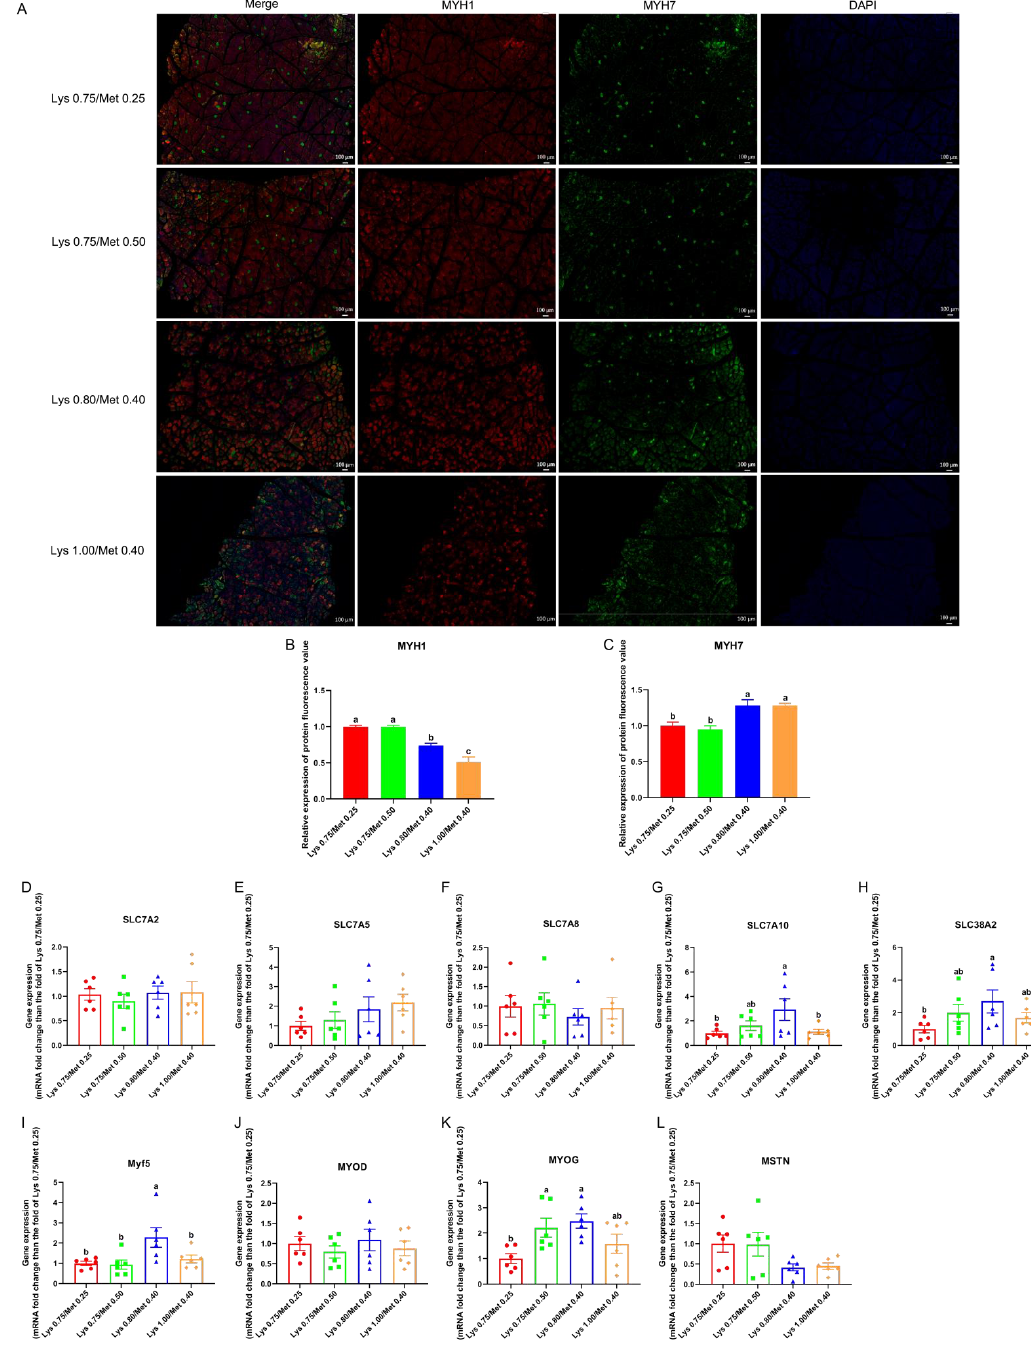
Figure 1. Effects of different lysine and methionine composition in diets on muscle fiber type and muscle tissue target gene expression in rabbits. ( A – C ) Muscle type detection (muscle tissue immunofluorescence). ( A ) MYH1 (red fluorescent, myosin–1; rabbit polyclonal fast myosin skeletal heavy chain antibody) and MYH7 (green fluorescent, myosin–7; rabbit polyclonal slow skeletal myosin heavy chain antibody). Quantification of MYH1 ( B ) fluorescence and MYH7 ( C ) fluorescence. ( D – H ): the expression of amino acid transporter protein-encoding genes. SLC7A2 (D), SLC7A5 (E), SLC7A8 (F), SLC7A10 ( G ), and SLC38A2 (H). ( I – L ): the expression of genes encoding muscle development-related regulatory factors. MYF5 (I), MYOD ( J ), MYOG ( K ), and MSTN ( L ). Data are expressed as means ± SEM ( n = 6). Comparisons between groups that contain only different lowercase letters indicate significant differences ( p <